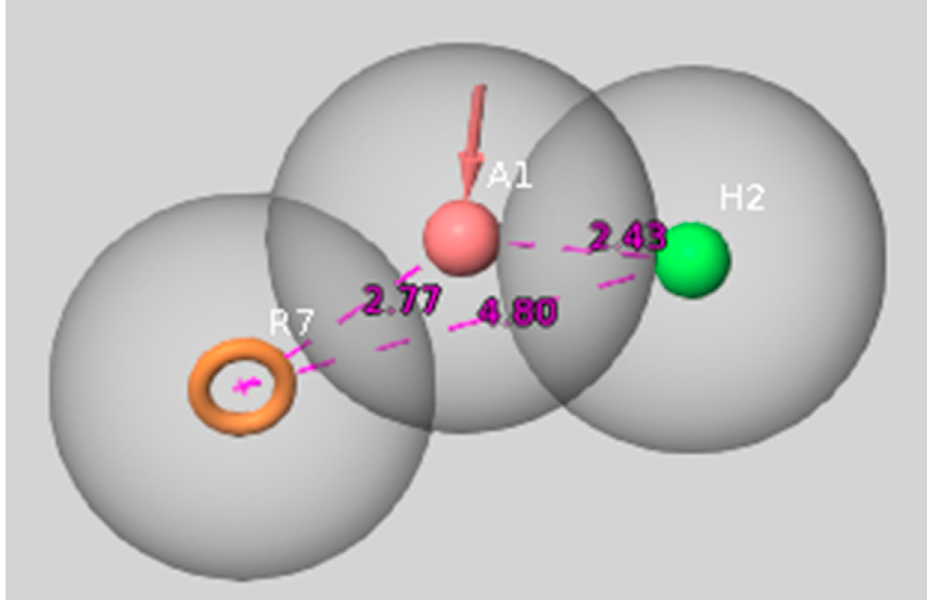
Figure 2. Pharmacophore model of the 5-HT 6 R ligands: aromatic moiety (R7), hydrogen bond acceptor (A1), hydrophobic moiety (H2).